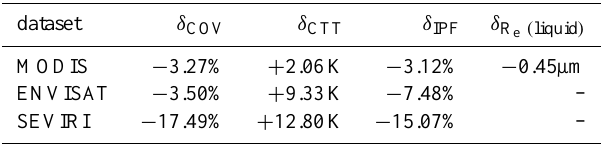
Table 3. Mean cloud property changes in the presence of dust, av- eraged with appropriate weighting of occurrence, throughout the years 2004–2008 as observed by the three different